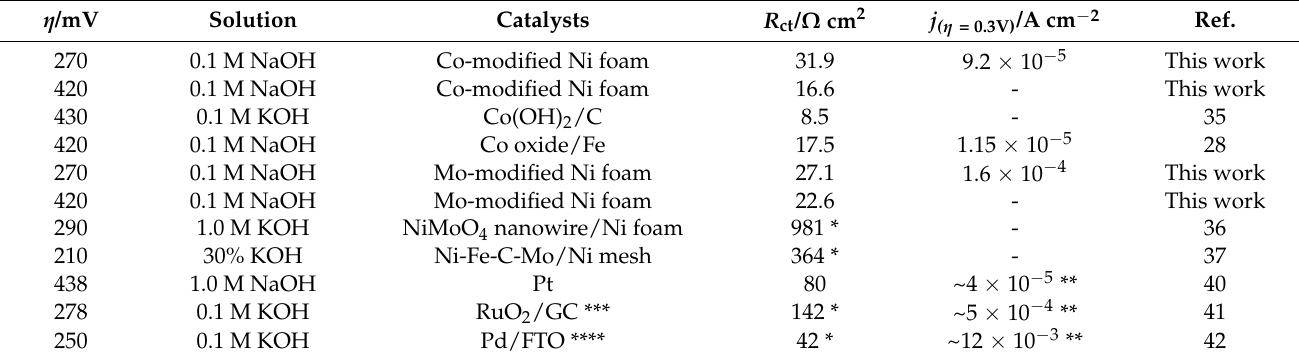
Table 3. Electrochemical parameters for the OER performed at the surfaces of different catalyst materials, under alkaline